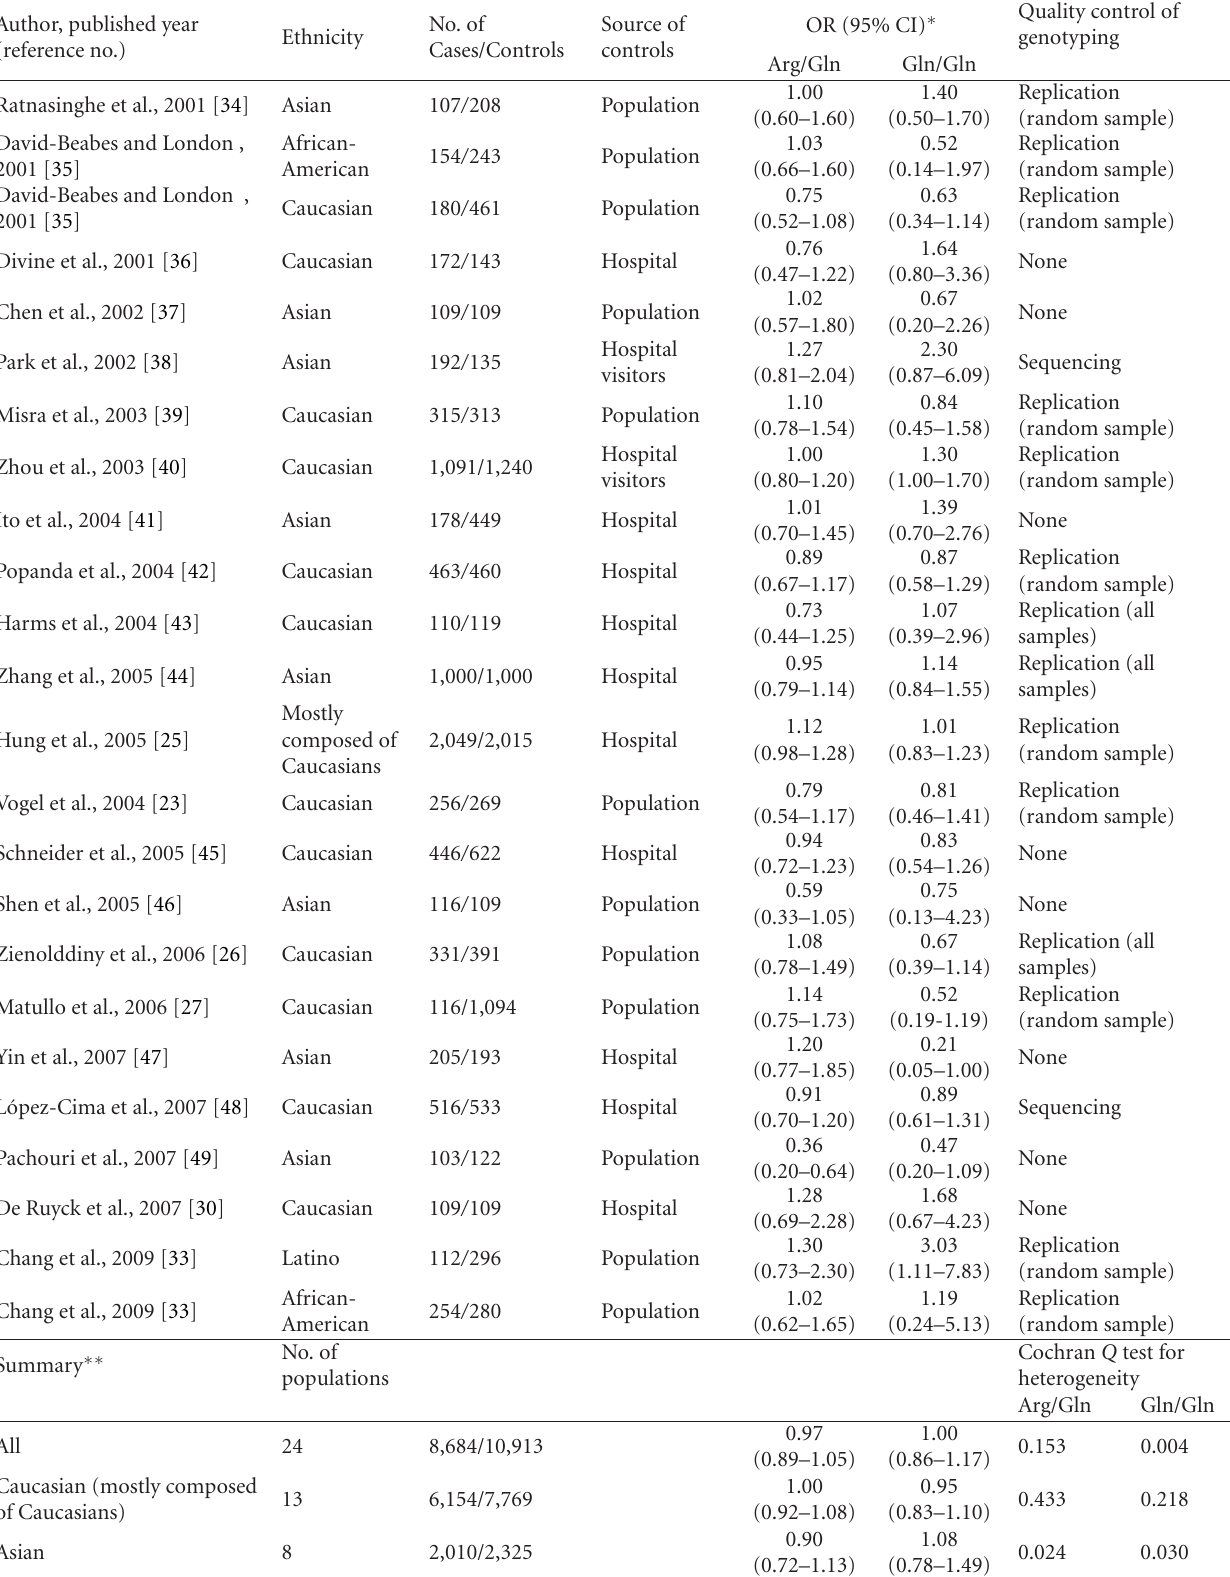
Table 3: Genetic polymorphisms in the BER pathway and lung cancer risk: XRCC1 Arg399Gln